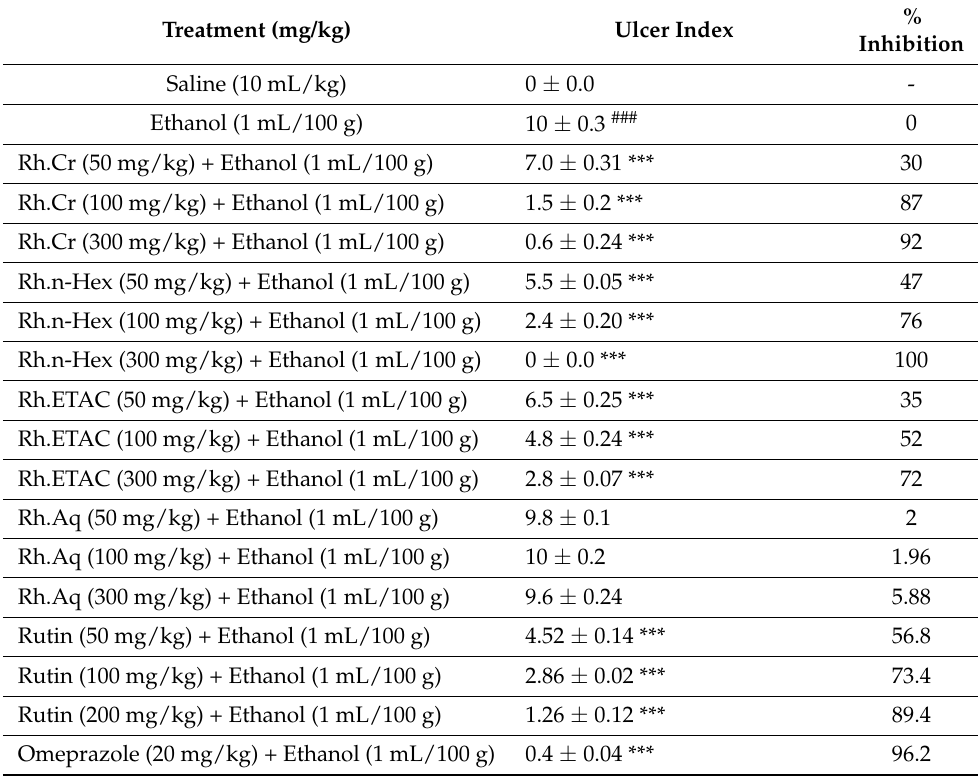
Table 7. Effect of Rumex hastatus crude extract (Rh.Cr) and fractions: n-hexane (Rh.n-Hex),